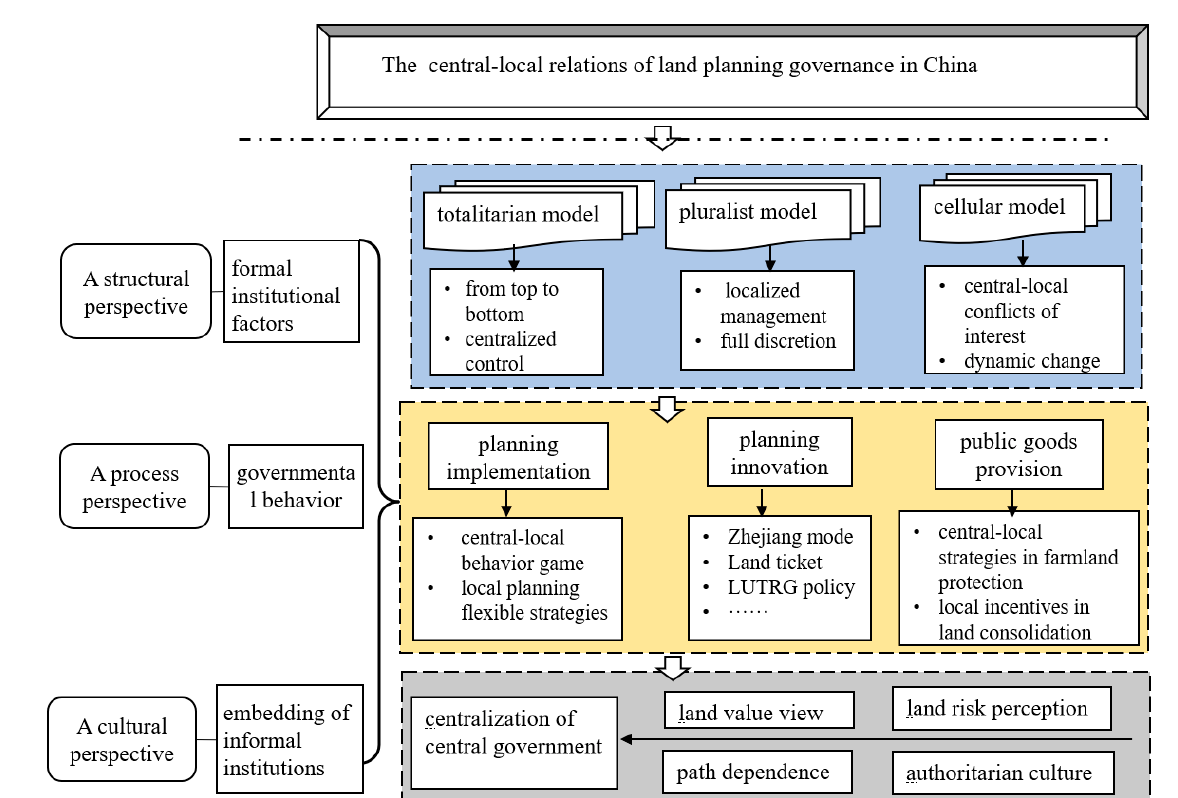
Figure 2. The knowledge mapping of research progress.